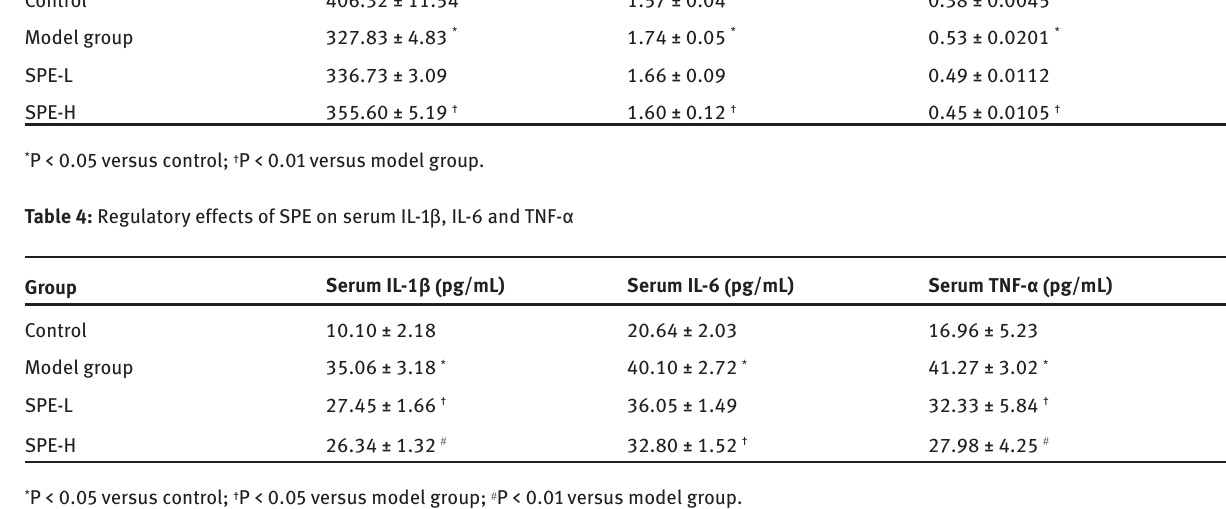
Table 3: Effects of SPE on body weight, renal weight and index in DN rats Group